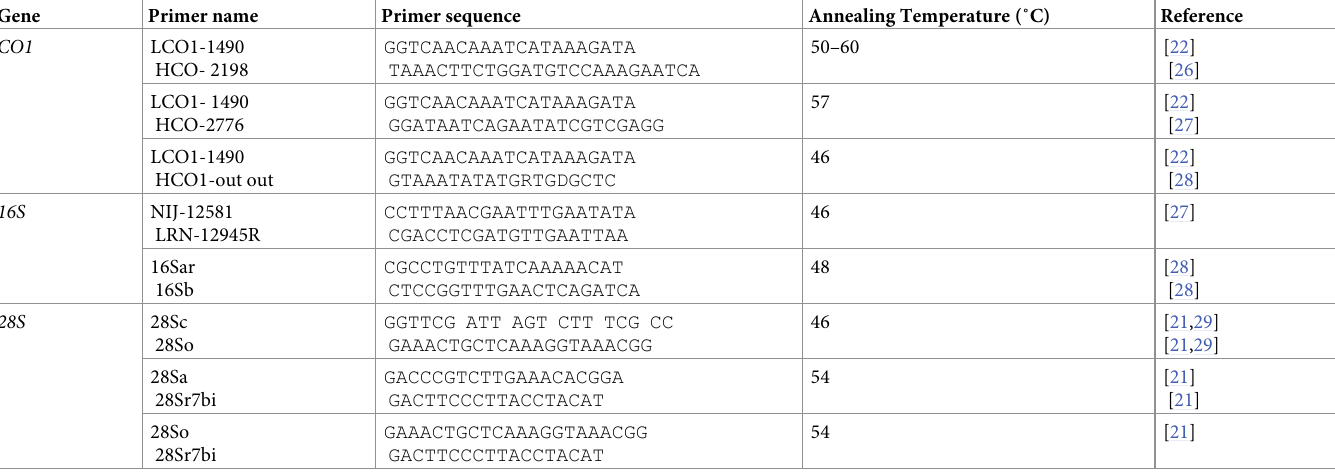
Table 2. Gene targets, PCR conditions and primer data used in this study.